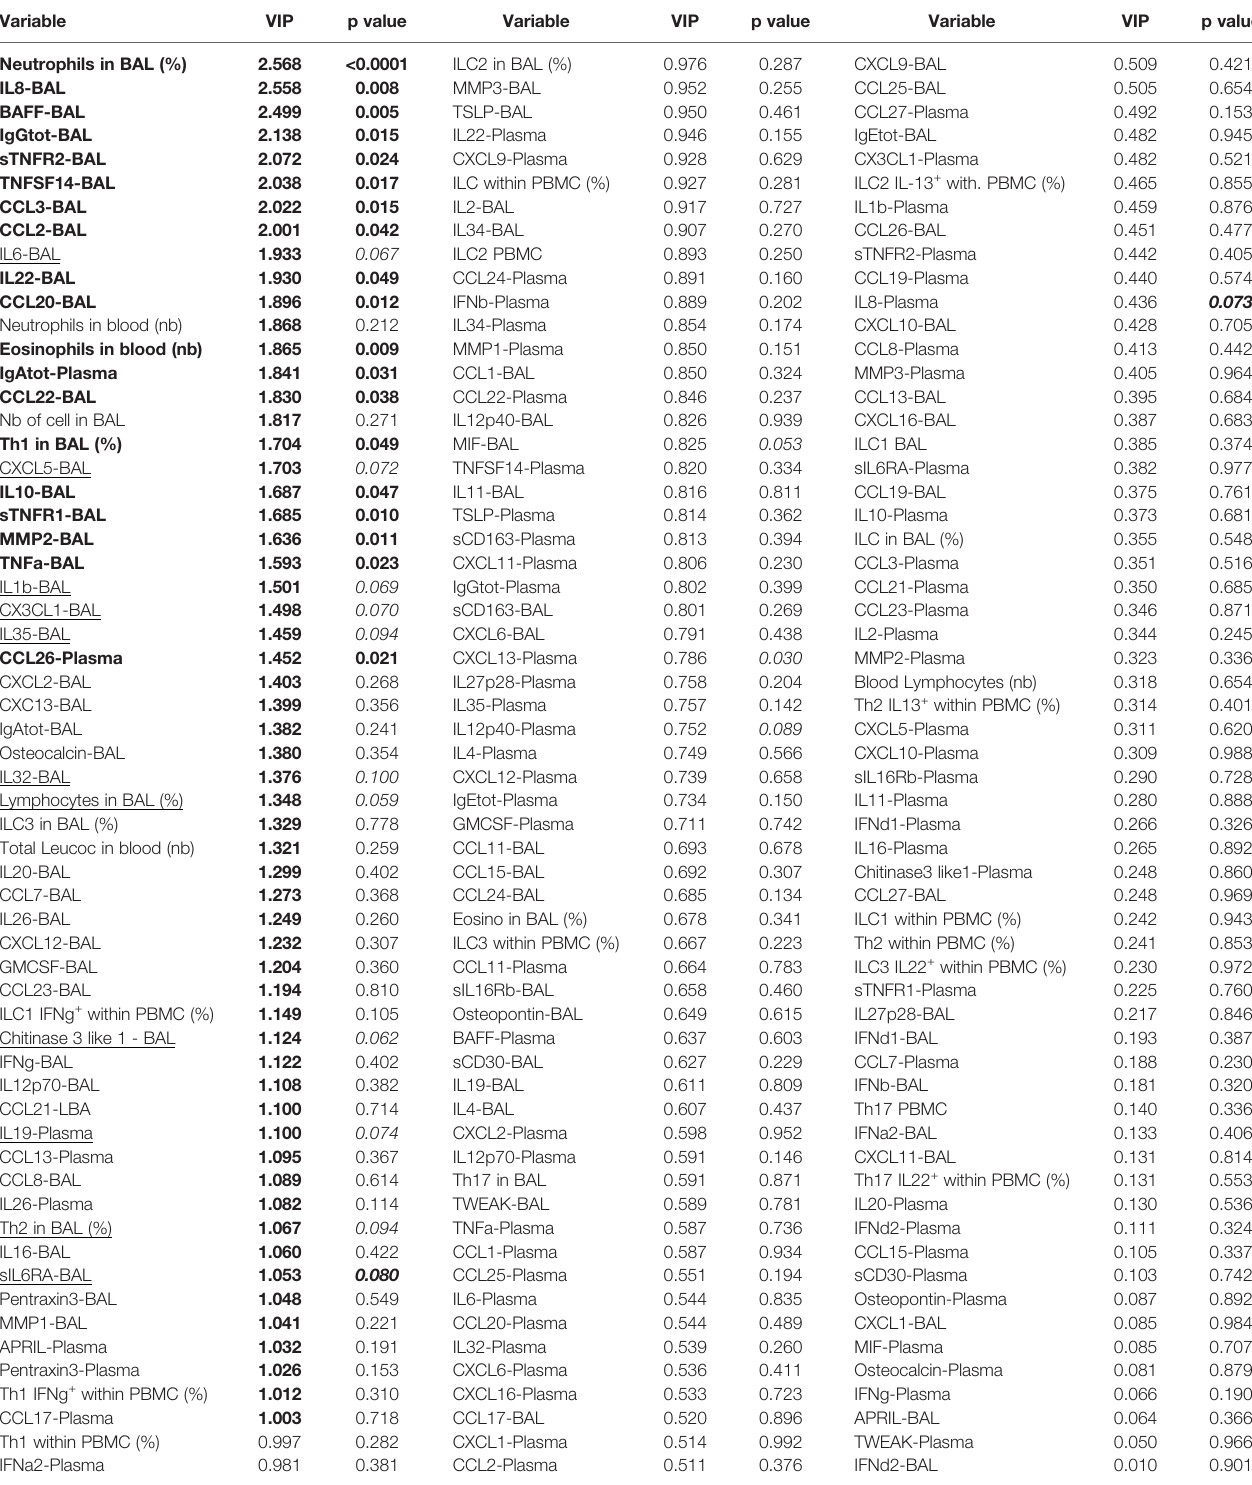
TABLE 2 | VIP values (PLS-DA) and p values (Mann Whitney) for all measured immune constituents for comparisons between children with SA and controls. Variable VIP p value Neutrophils in BAL